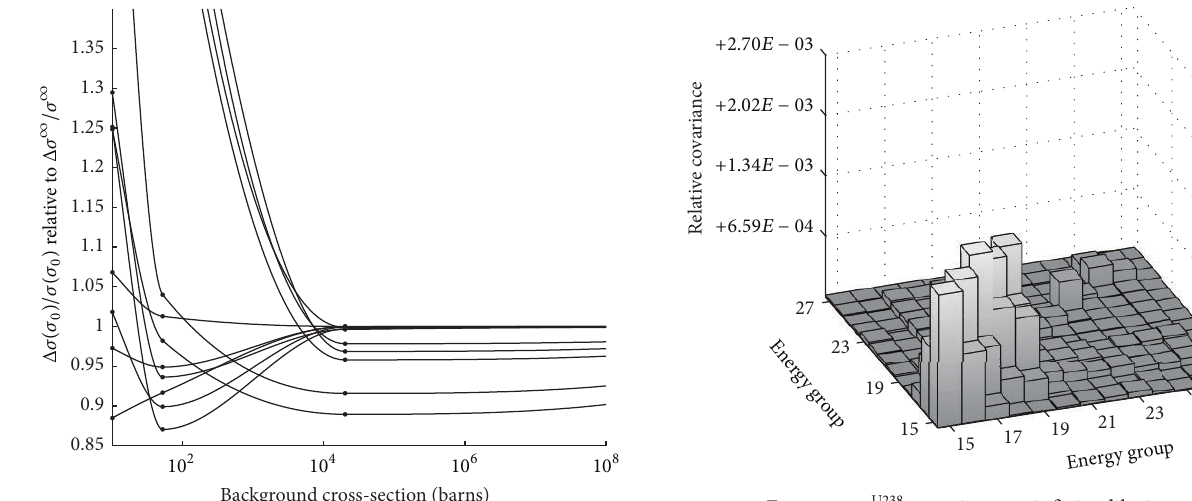
Figure 7: 𝜎 U 238 𝛾 covariance at infinite dilution.